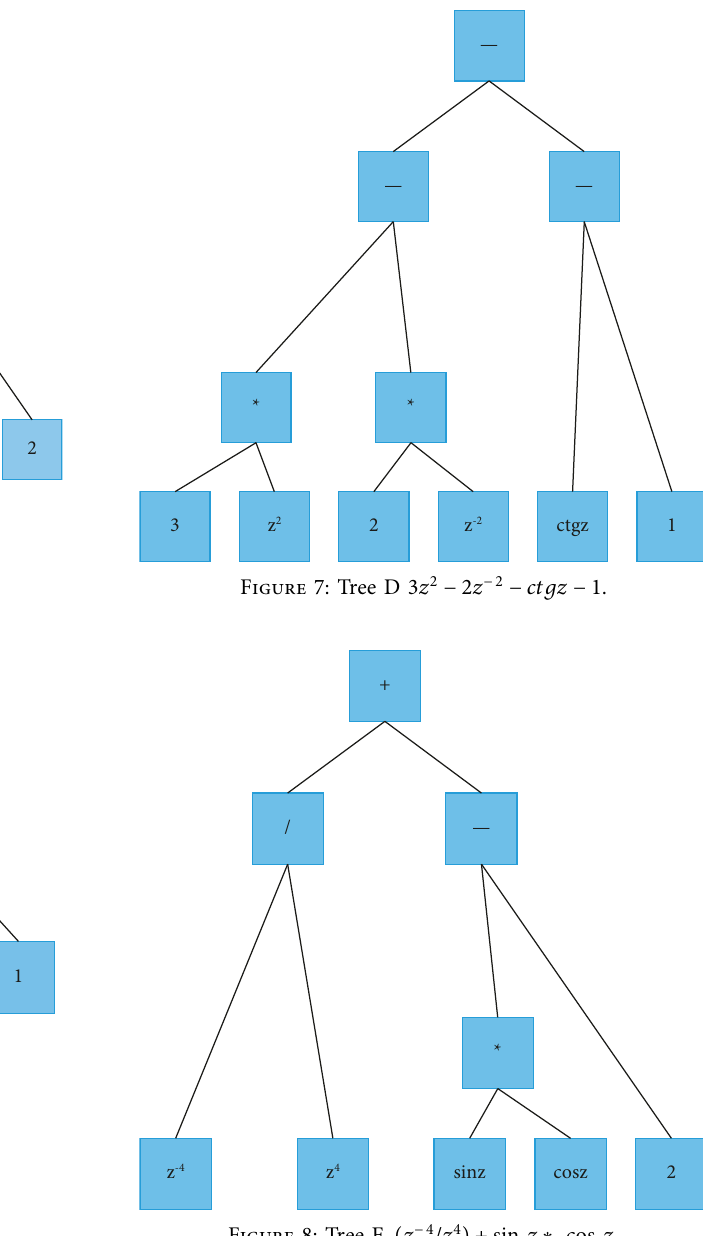
Figure 8: Tree E ( z − 4 / z 4 ) + sin z ∗ cos z